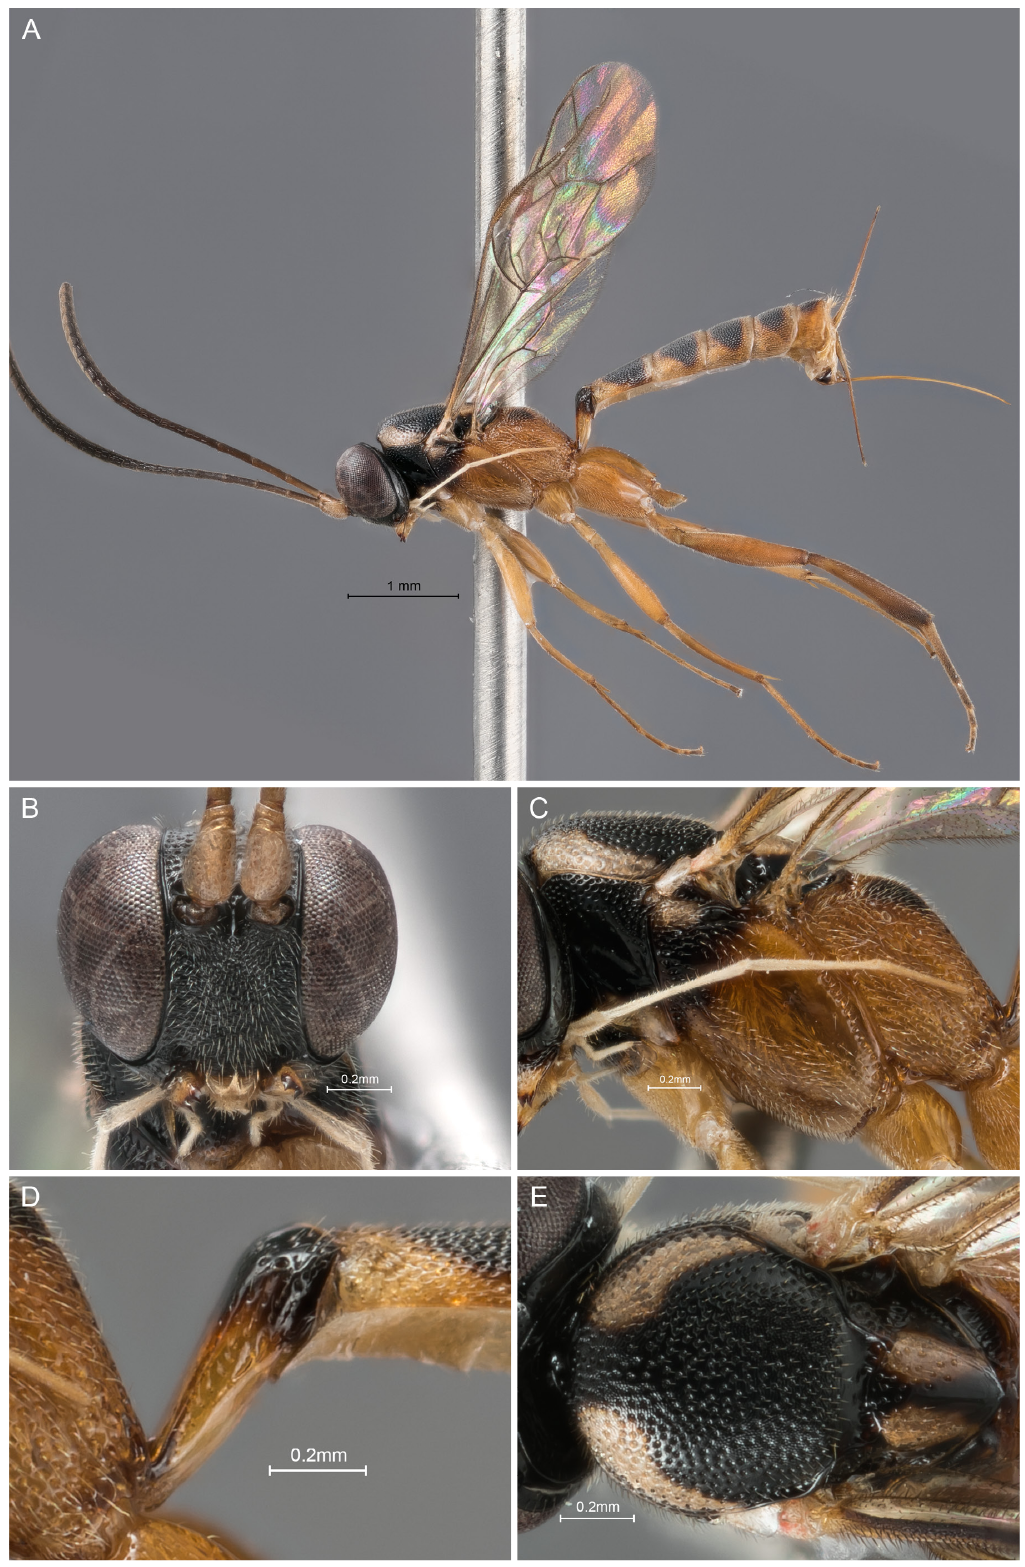
Fig. 17. Palpostilpnus tamasek sp. nov., holotype, ♀ (LKCNHM). A . Lateral habitus. B . Head, anterior view. C . Mesopleuron. D . T1, lateral view. E .